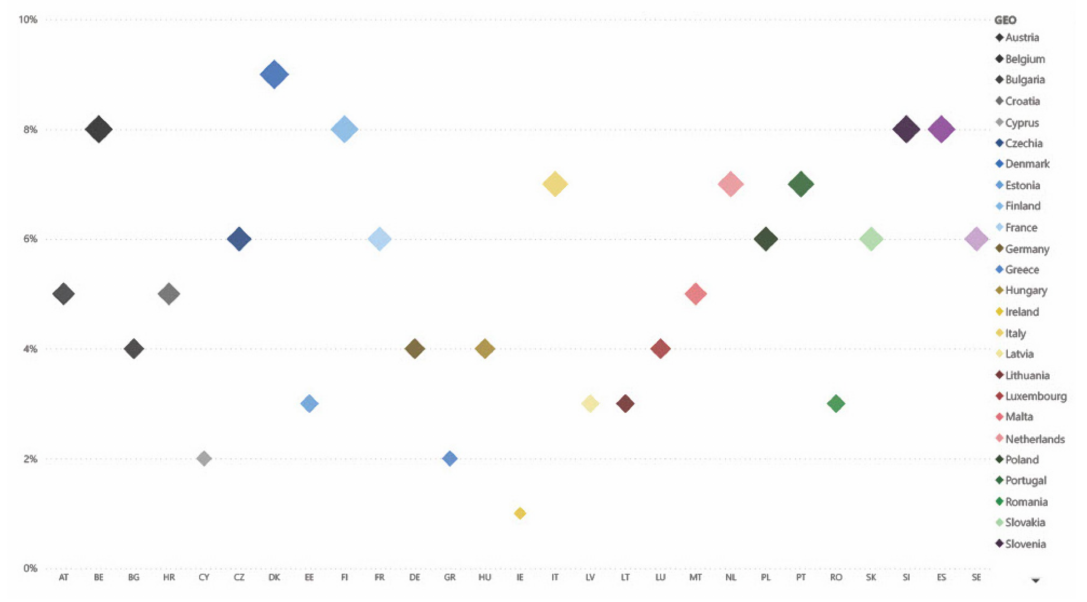
Figure 5. Share of enterprises using industrial robots in 2020, by country. Source: Author’s Con- tribution. Data retrieved from Eurostat. Robotics and 3D Printing Data, https://ec.europa.eu/ eurostat/databrowser/bookmark/f29db2df-2e19-4bfd-8bb4-af630dc3e907?lang=en, accessed on 9 January